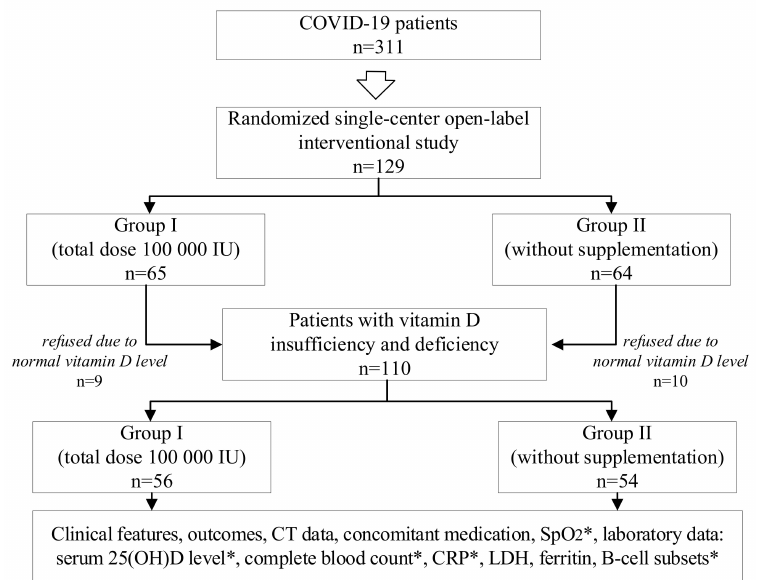
Figure 1. Study design. CT, computed tomography; SpO2, oxygen saturation; 25(OH)D, 25-hydroxyvitamin D; CRP, C-reactive protein; LDH, lactate dehydrogenase; *, both on the 1st and at the 9th